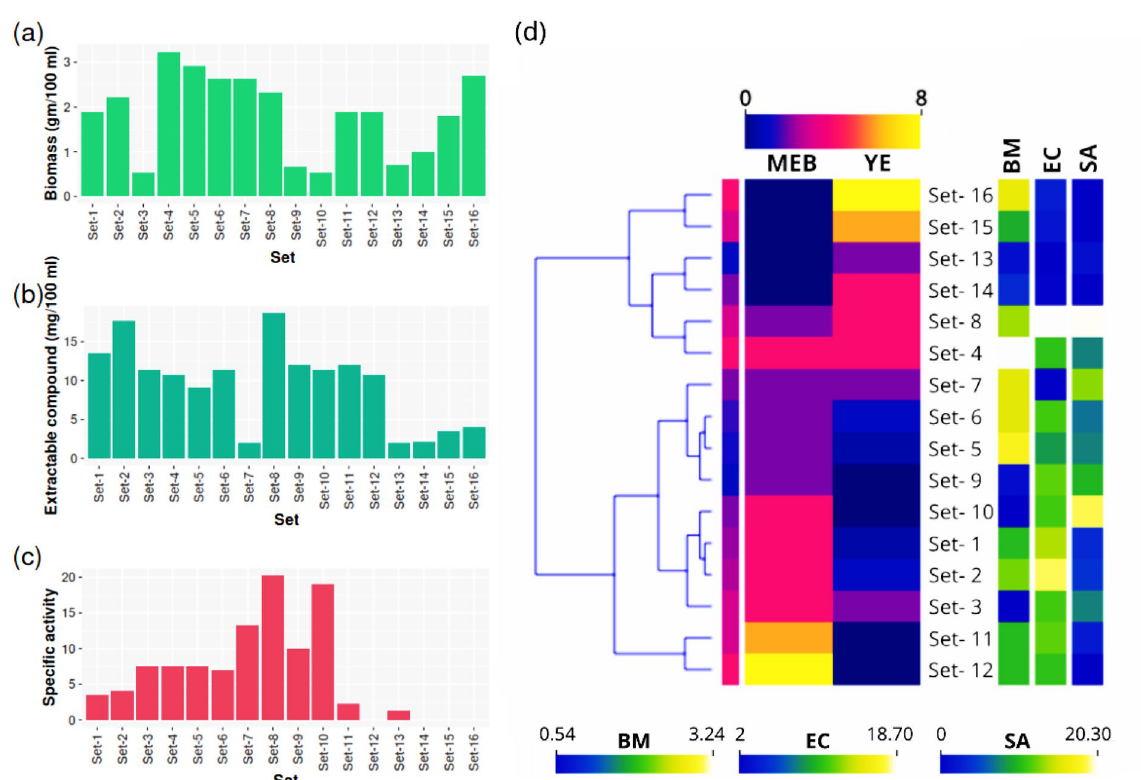
Figure 1. Bar plots ( a – c ) of production parameters from different sets of media composition. ( a ) biomass (BM), ( b ) extractable compound (EC), ( c ) specific activity (SA). ( d ) Heatmap showing clustering the similar media based on production